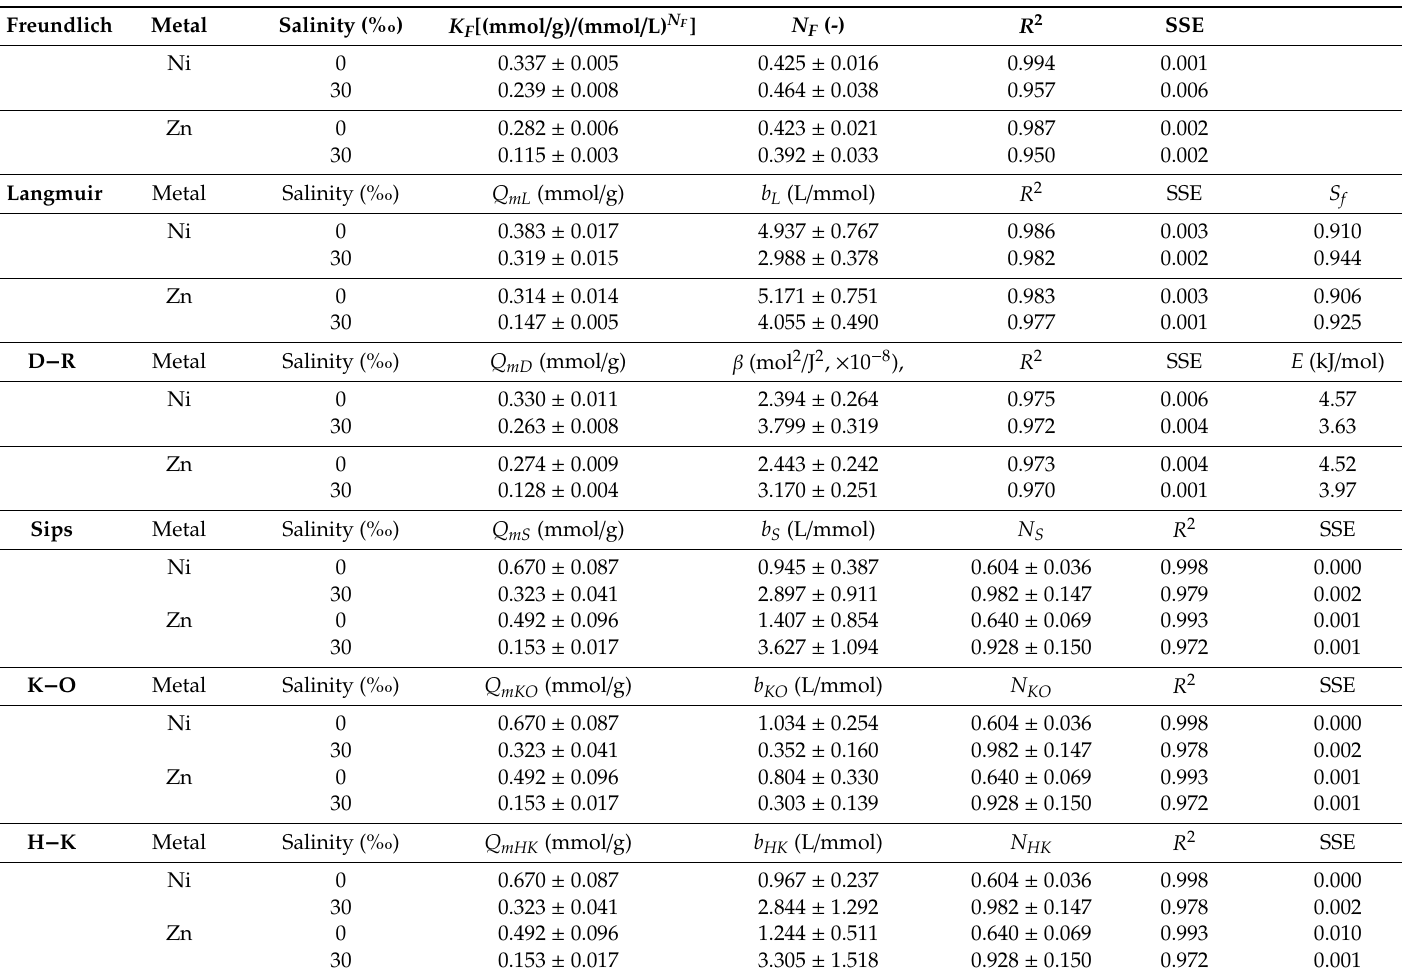
Table 3. Adsorption model parameters for single adsorption of Ni and Zn onto PINM at pH 5. * Calculated at C w ,0 = 0.02